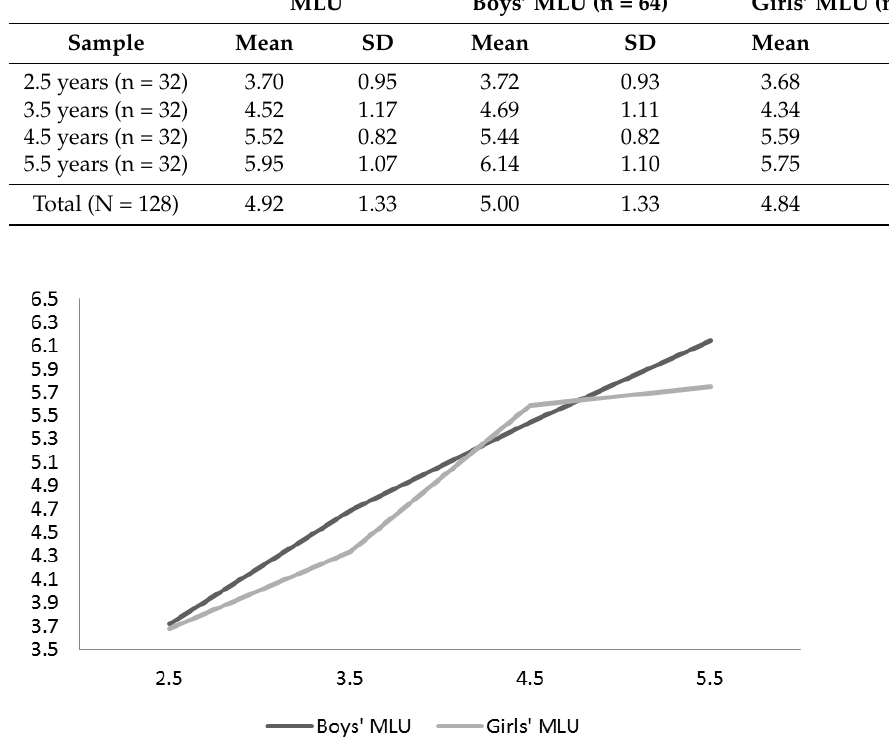
Figure 2. Gender differences in MLU for the subsample (N = 128).